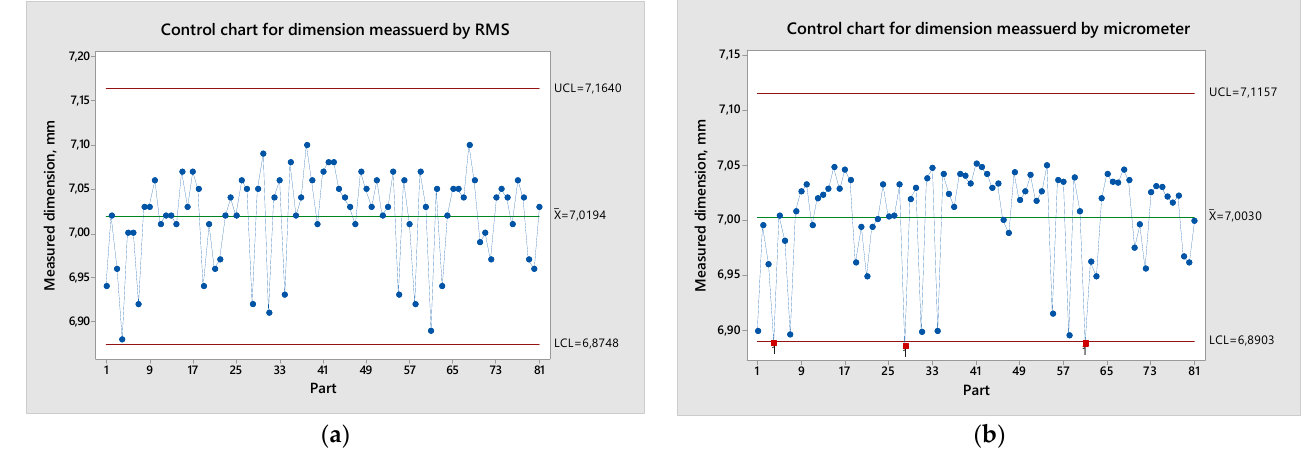
Figure 11. Individual control chart of 81 measured values (blue) on two different types of systems: ( a ) control chart of measured values by RMS; ( b ) control chart of measured values by a micrometer.